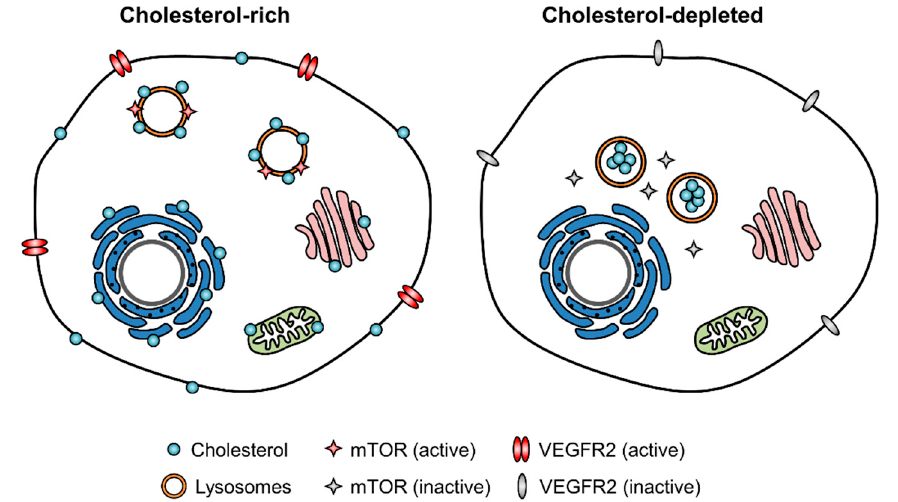
Figure 3. Endothelial cell cholesterol level and angiogenic signaling molecules. The proper level of cholesterol in the membrane is critical for membrane structure and the function of membrane binding angiogenic signaling proteins, such as mTOR and VEGFR2. Depletion of cholesterol by the inhibition of cholesterol trafficking leads to the dissociation of mTOR from the lysosomal membrane and the inhibition of VEGFR2 dimerization on the cell membrane, causing the inhibition of their signaling pathways.